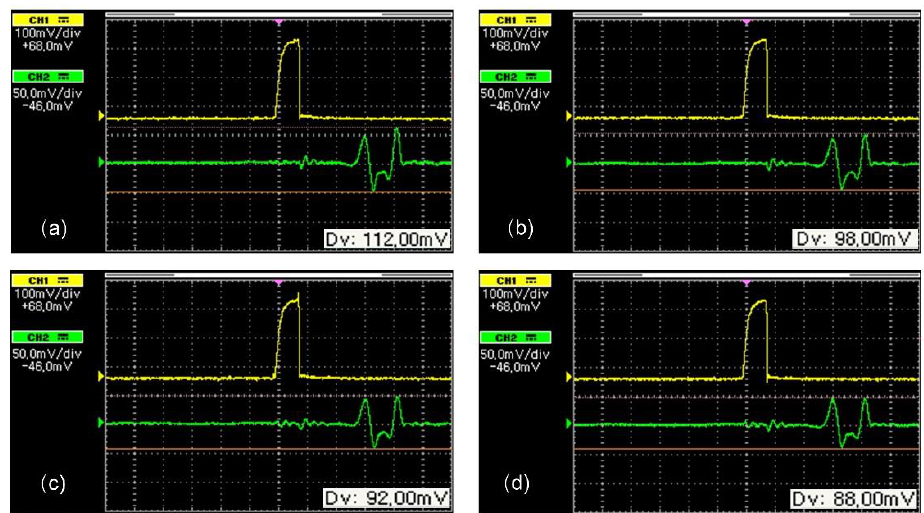
Figure 9. The response of the sensor of Figure 4a with respect to the permeability of the under-test steel, for various voltage inputs to the Π shaped 7 ppm carbon soft iron electromagnetic yoke: ( a ) 1 V; ( b ) 5 V; ( c ) 8 V; ( d ) 10 V.